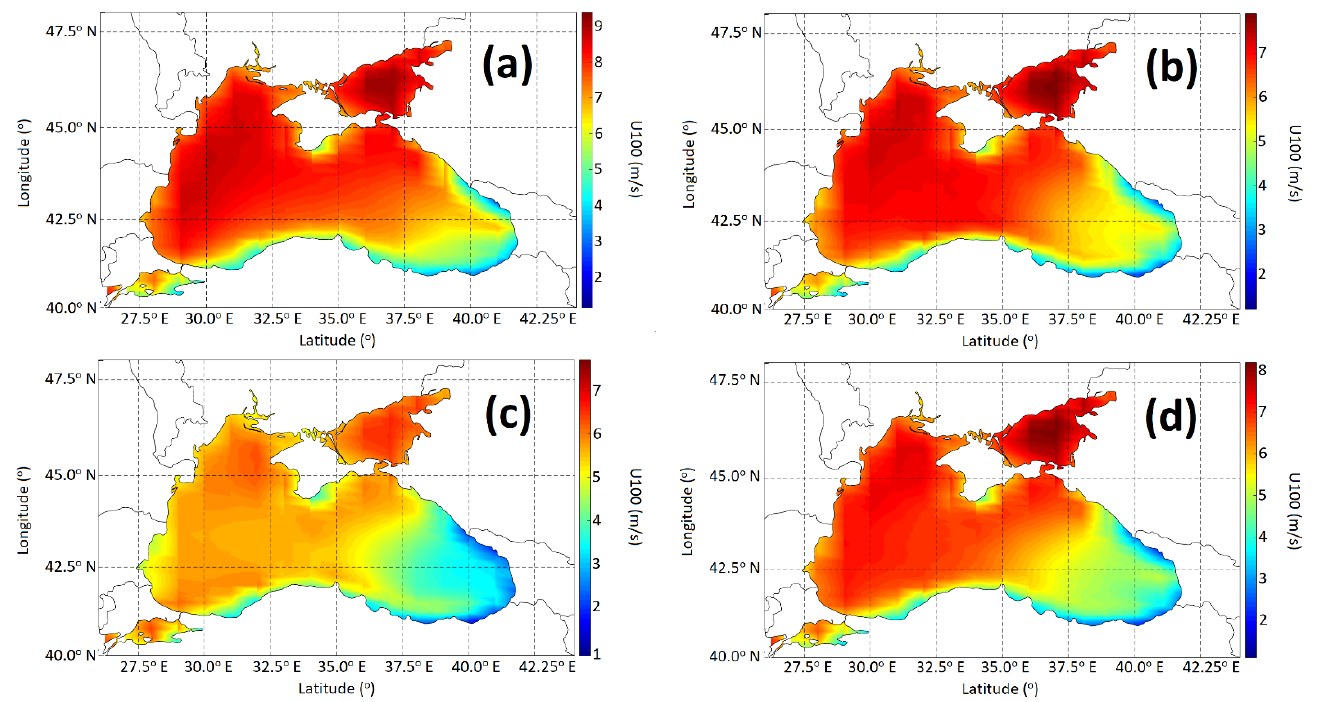
Figure 3. U100 seasonal distribution (average values) based on the ERA5 dataset for the time interval 2002 – 2021: ( a ) winter; ( b ) spring; ( c ) summer; ( d ) autumn.